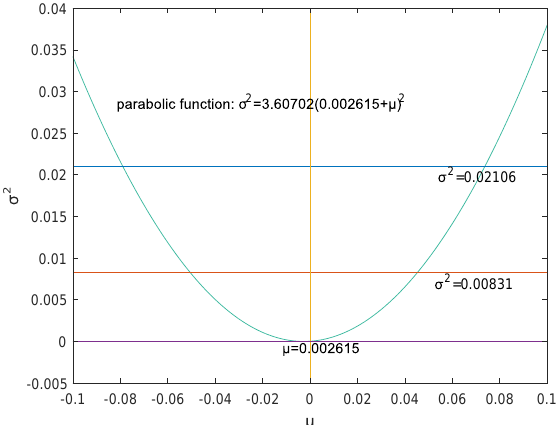
Figure 6. The joint confidence region of ( µ , σ 2 ) by ideal point method.